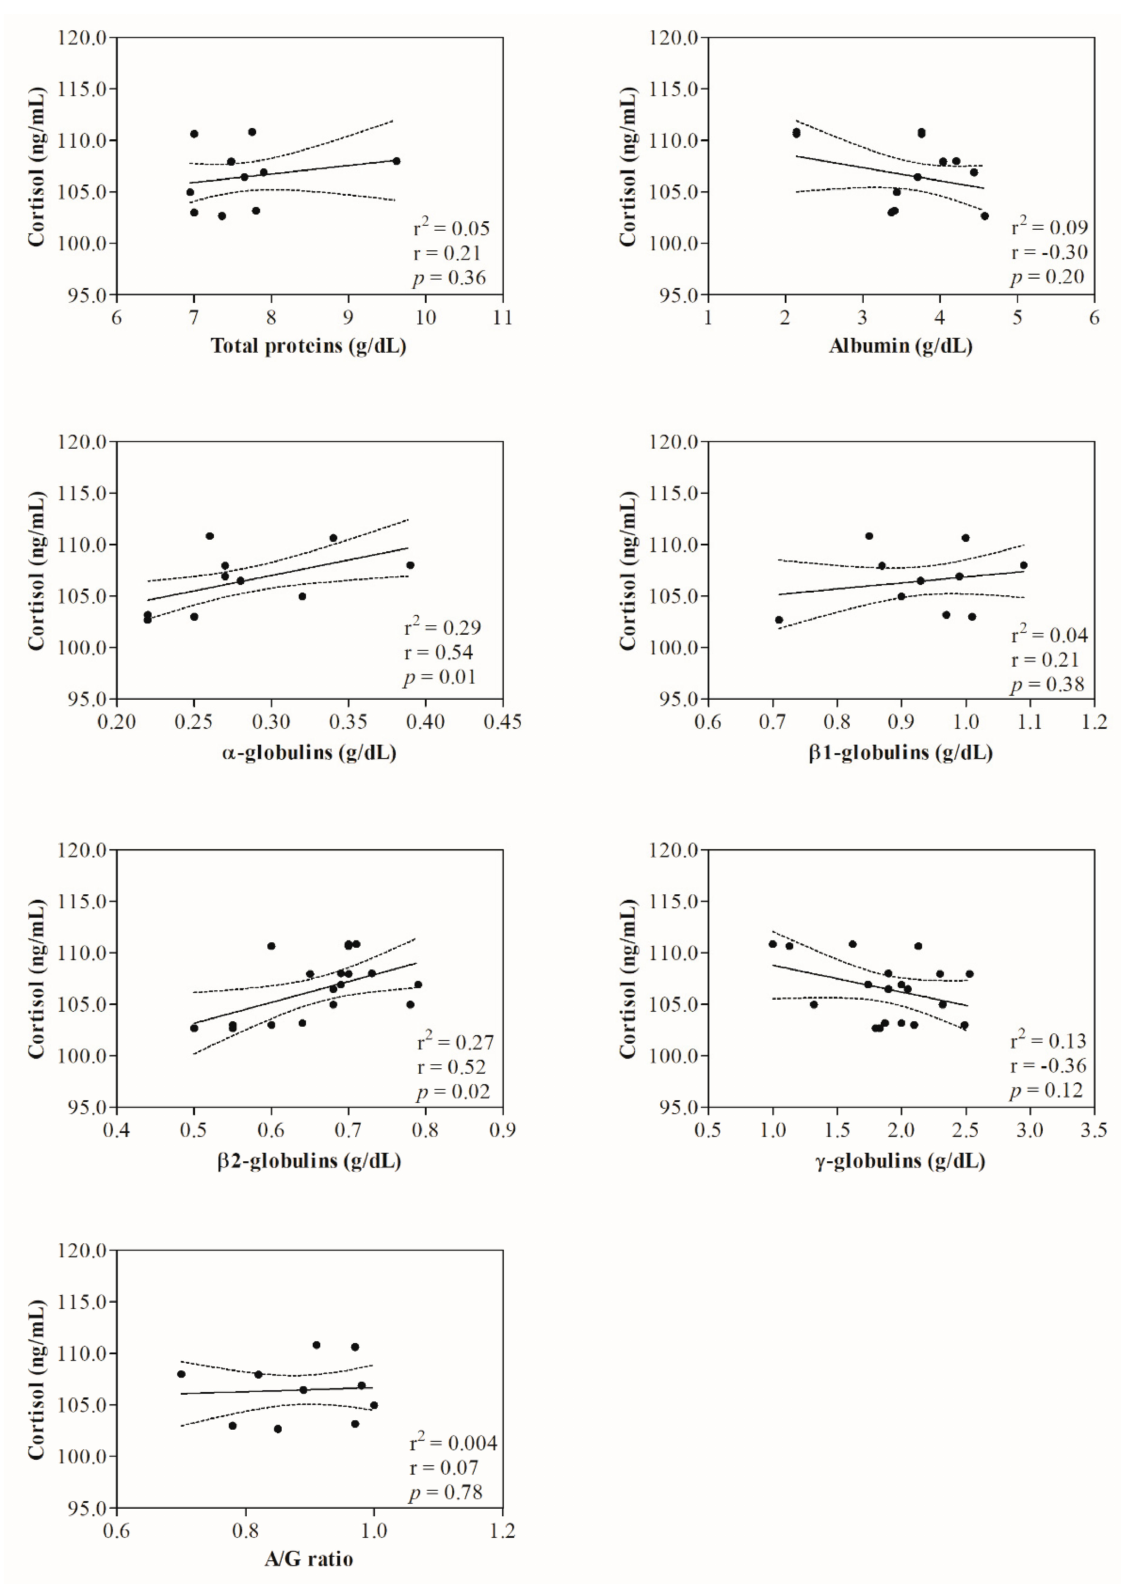
Figure 3. Linear regression model results found between the serum values of cortisol and the serum levels of total proteins, albumin, α -, β 1-, β 2-, γ -globulins and the A/G ratio measured in ewesafter 5 min from the end of the shearing procedure (T POST5